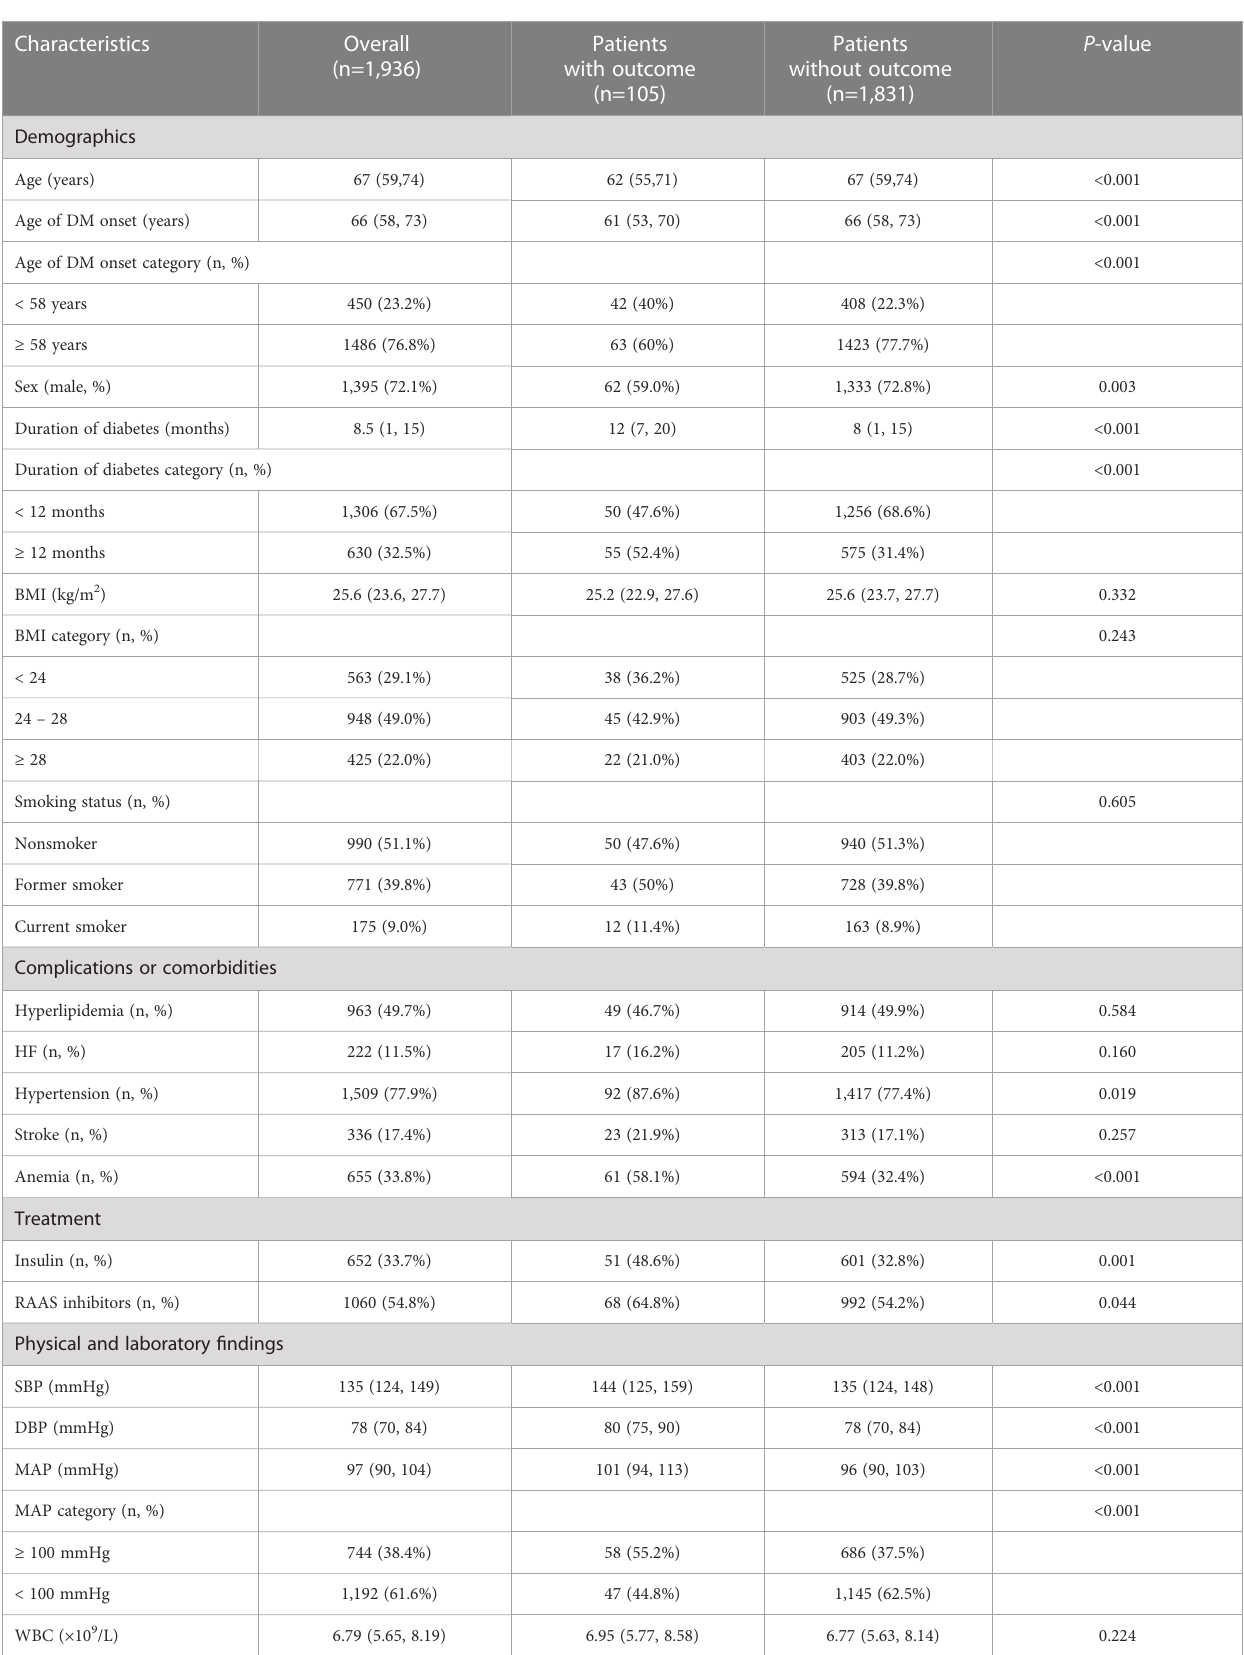
TABLE 1 Baseline clinical characteristics of the study